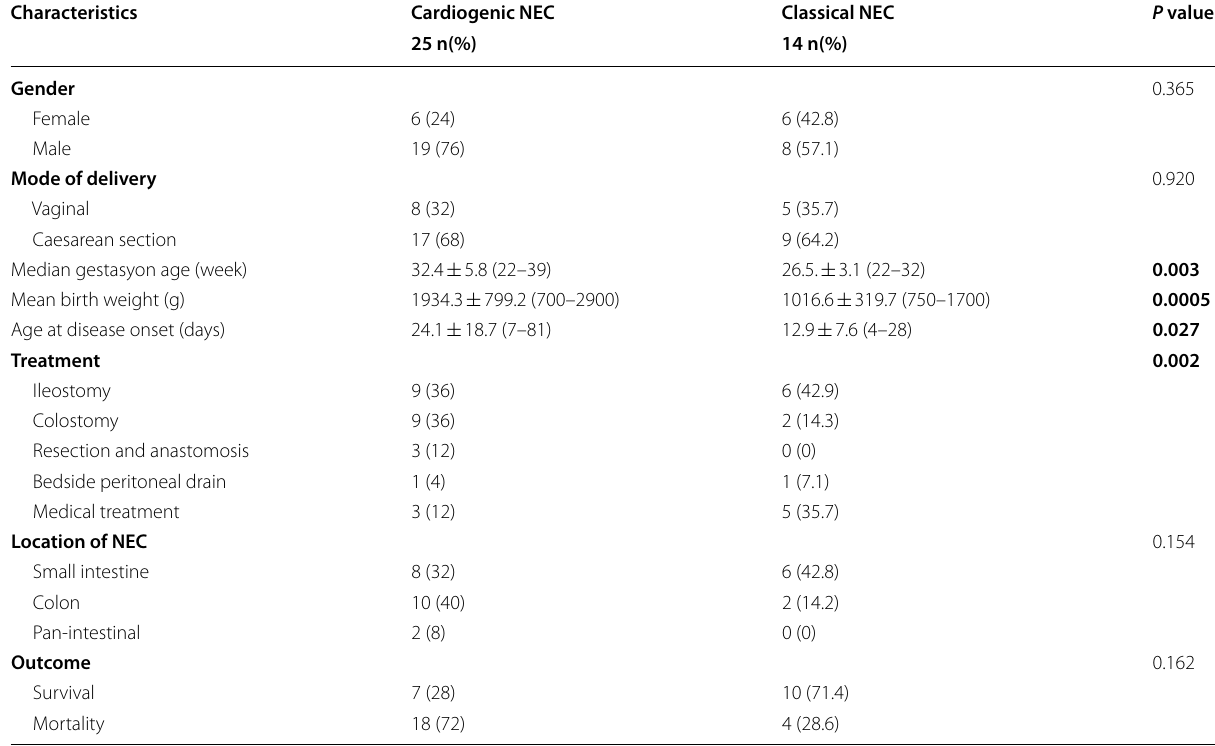
NEC Necrotizing